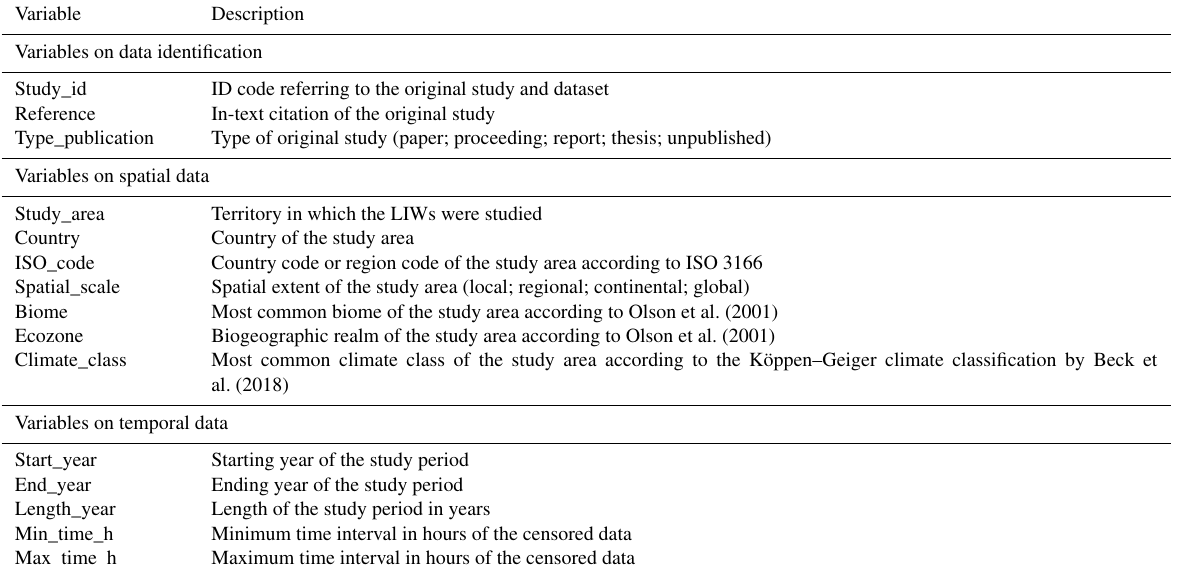
Table 2. Overview of the variables of ancillary data from the database on holdover time of LIWs.